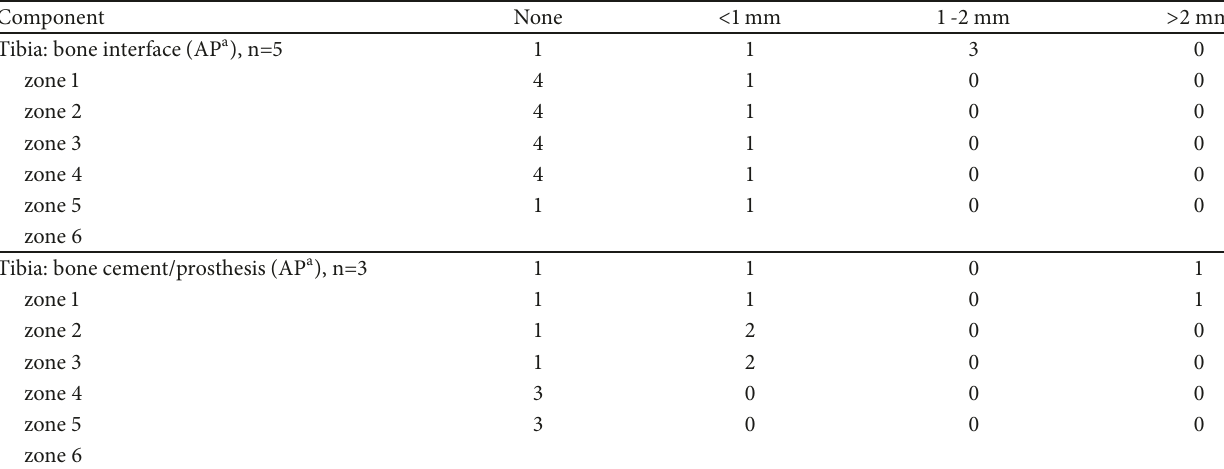
Table 9: The proportion of radiolucent line widths per tibial